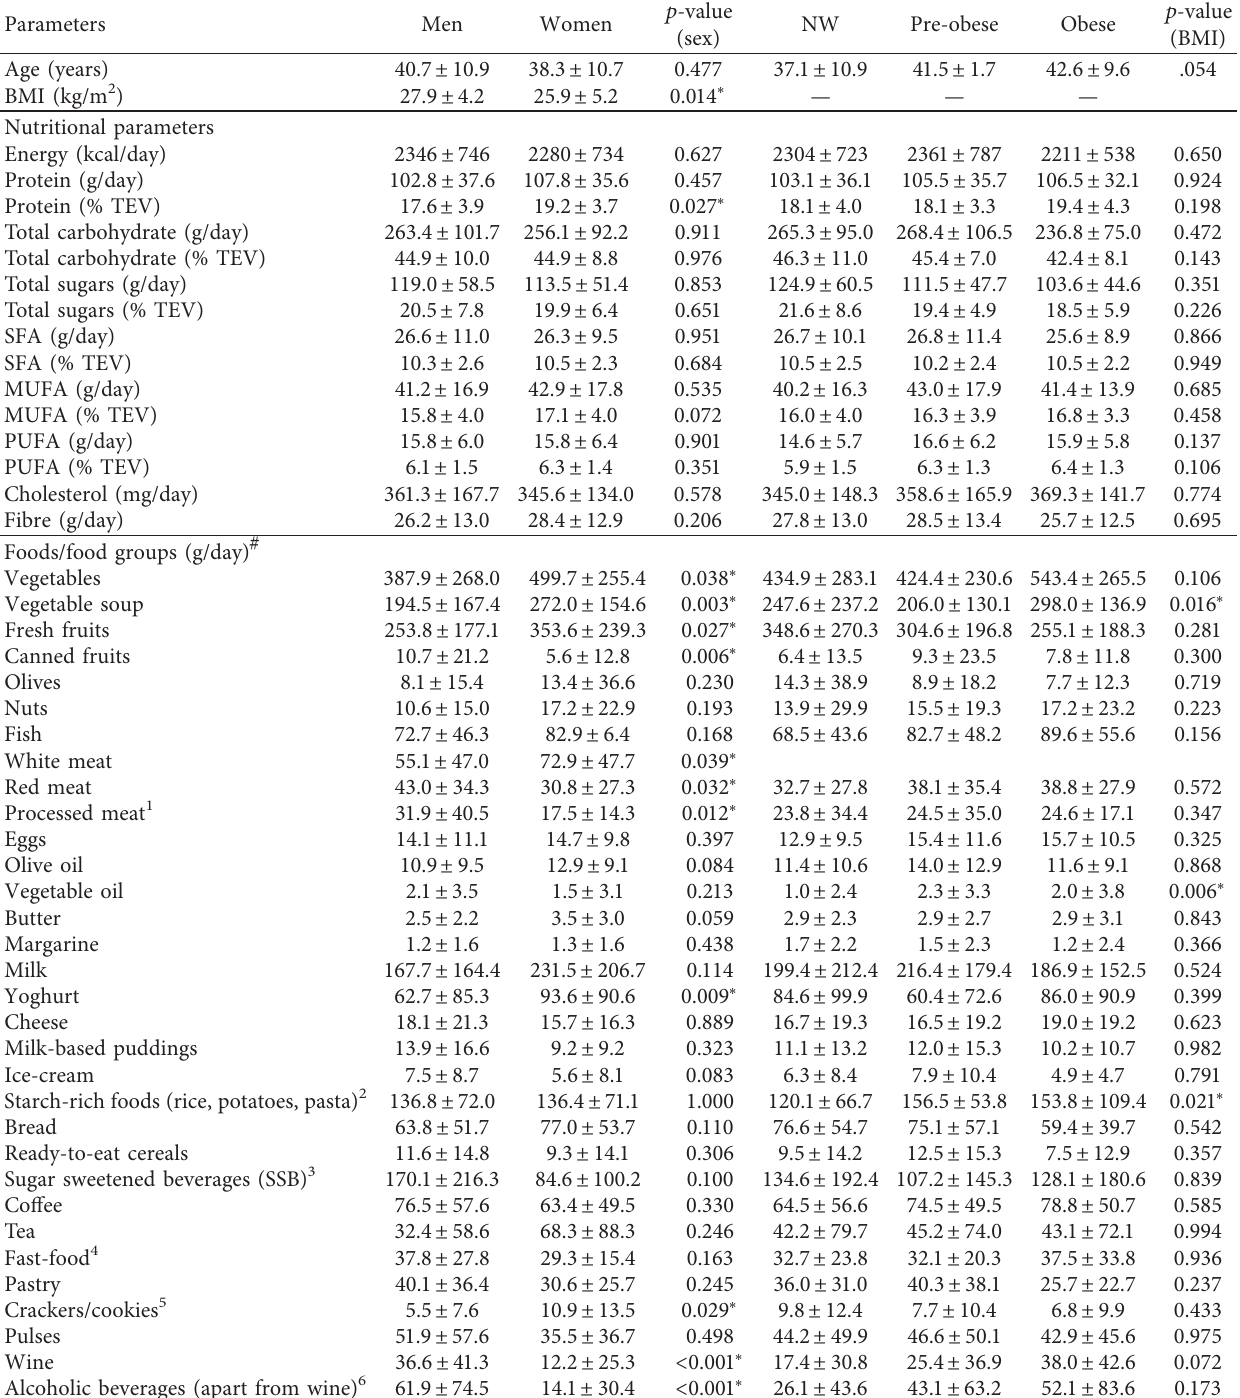
Table 1: Sample characteristics, nutritional, and food intake differences between sexes and BMI (values are mean ± standard deviation